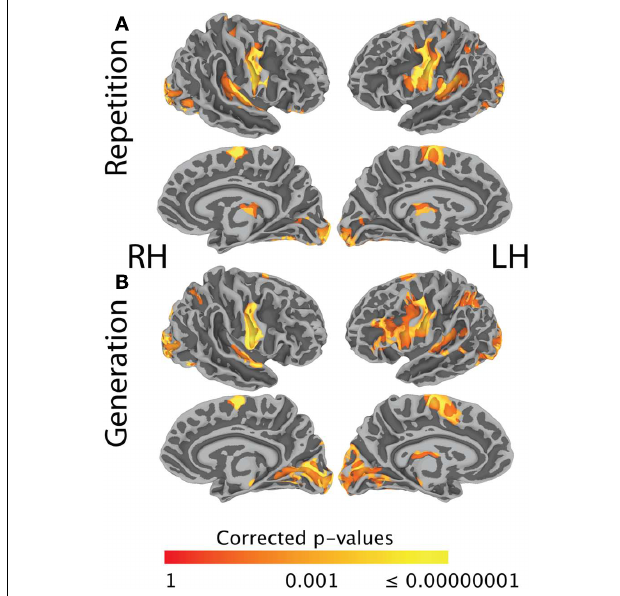
FIGURE 2 | (A) Shows FWE-corrected group-level ( N = 20) task-related activation during sentence repetition, after removing the effect of sentence listening. (B) Shows FWE-corrected group-level ( N = 20) task-related activation during sentence generation, after removing the effect of picture observation. Activation is shown on the group average smoothed white matter folded